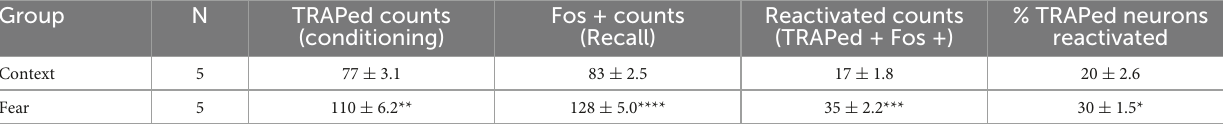
Fos + counts (Recall)